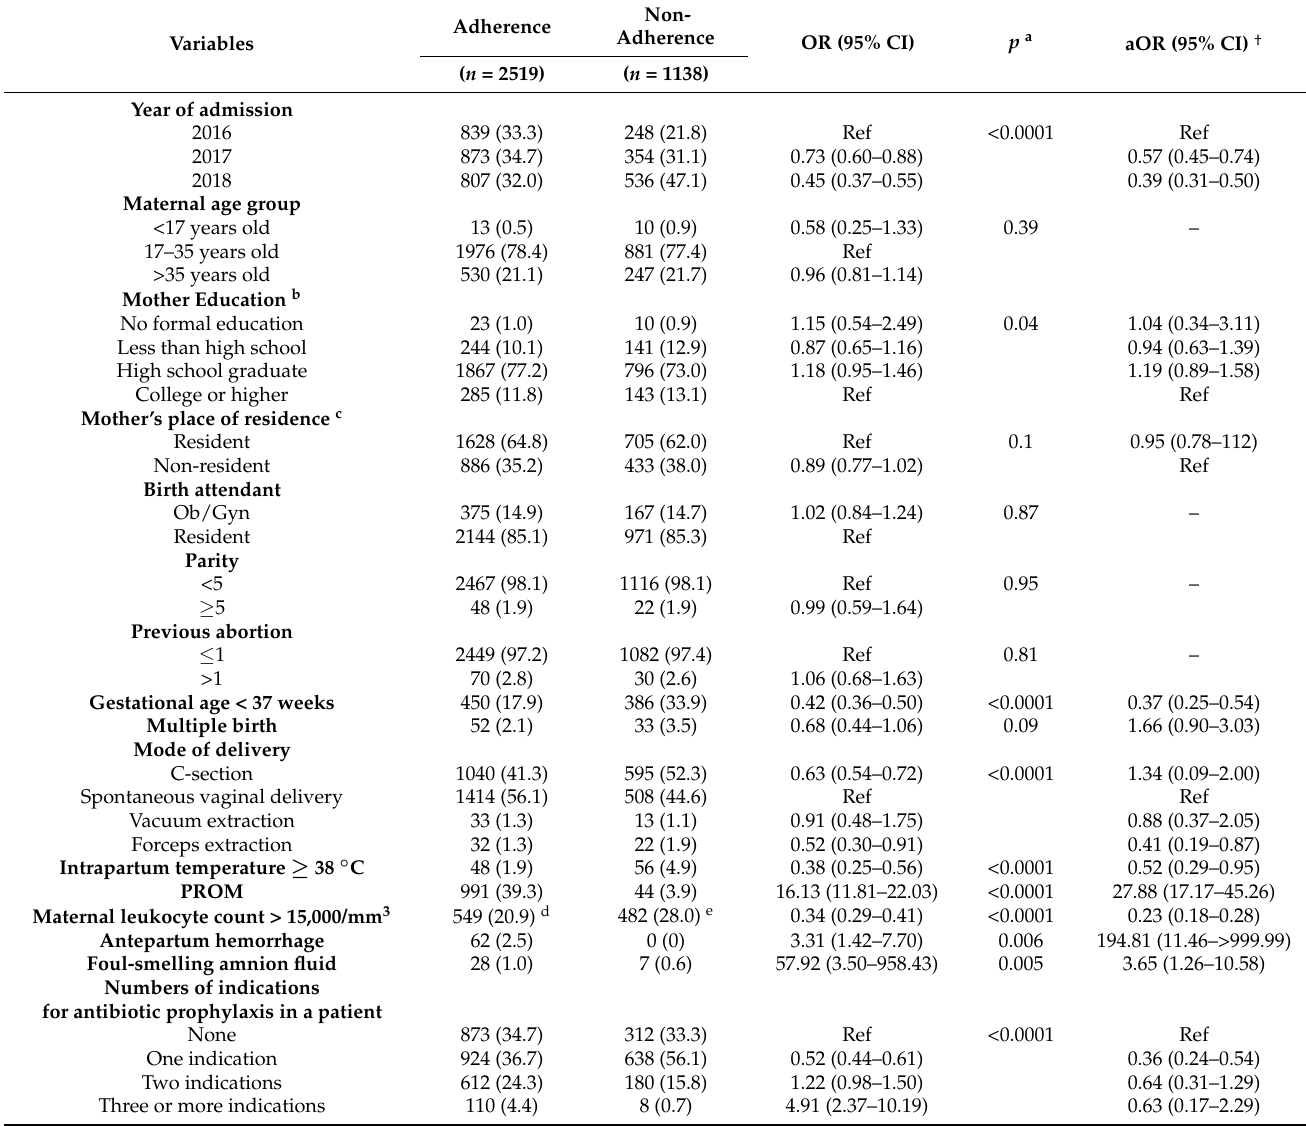
Table 3. Adherence to local prophylactic antibiotic prescribing